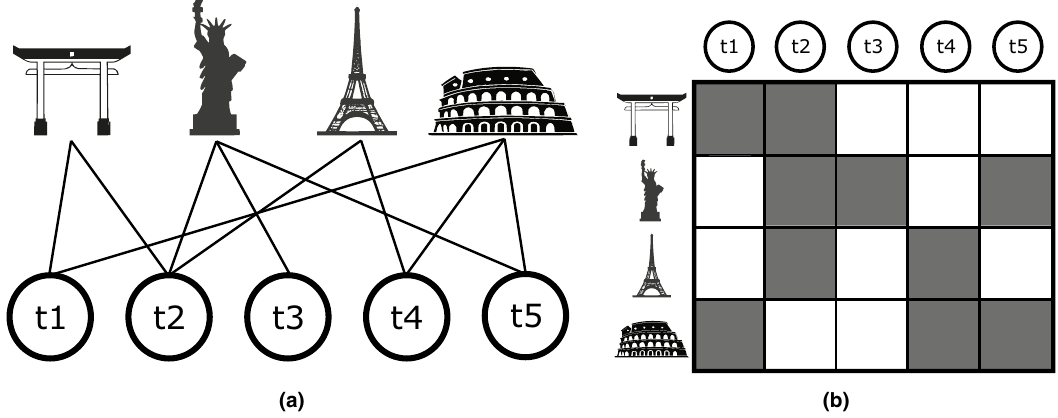
Figure 1. Bipartite metropolitan areas—technology codes network. (a) Pictorial representation of the bipartite metropolitan areas-technology codes network. Each MA is connected to one or more technology sectors. (b) Pictorial representation of the bipartite network adjacency matrix. A dark square means that a given technology code is present in a patent made by a given MA, and therefore a link is present in the bipartite